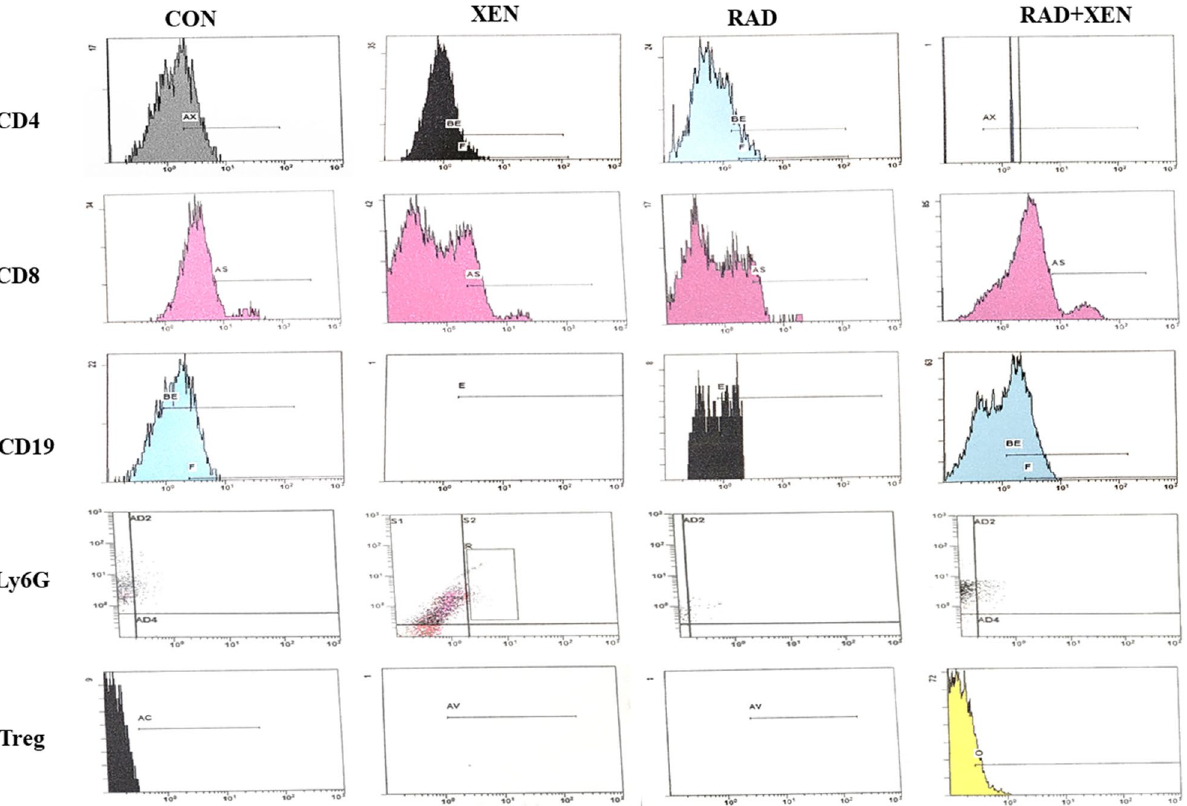
Figure 2. Representative plots of the CD4 + , CD8 + , Treg, CD19, and Ly6G in the spleen tissue on the 3rd day after gamma radiation in mice. The plots were only shown in one